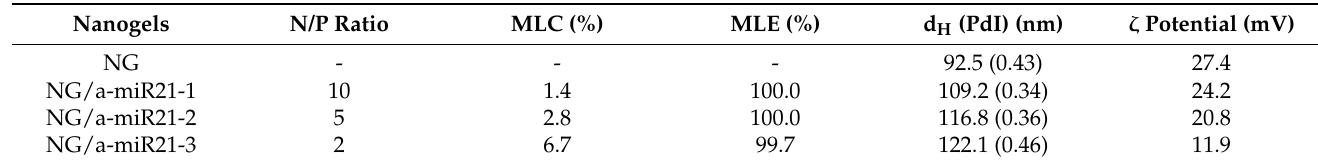
Table 1. Physicochemical properties of bare nanogels and after loading with a-miR21 at different N/P ratios.